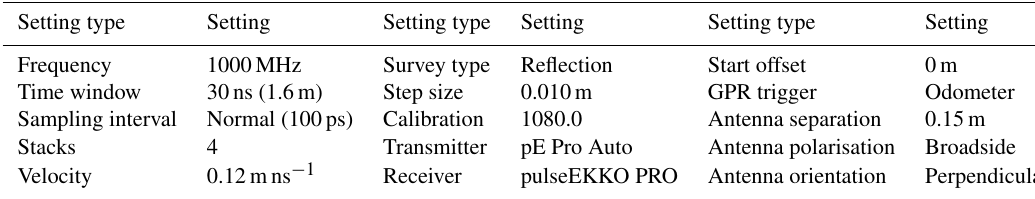
Table B1. System settings of the pulseEKKO PRO GPR